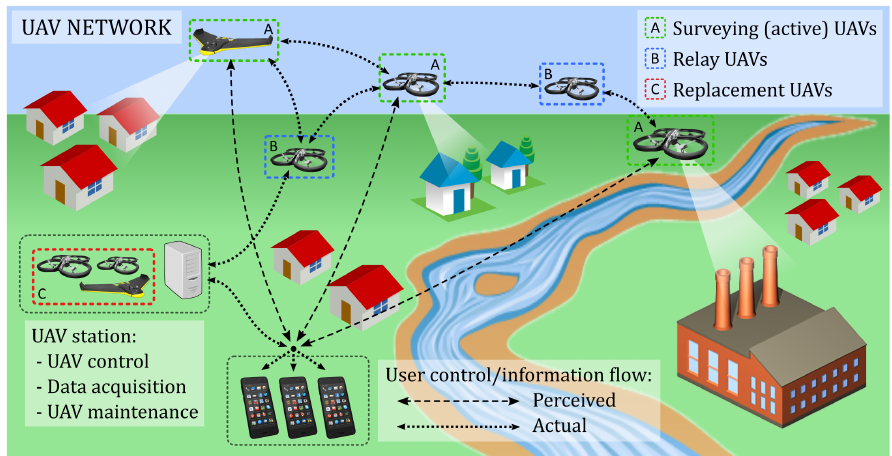
Figure 2. UAV network used for surveillance and communication support.